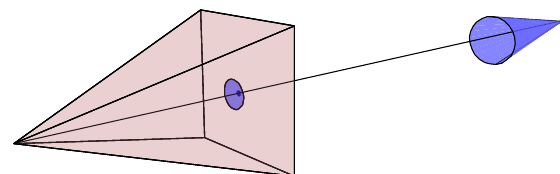
Figure 3: Visualization in refine mode. A virtual cone is gen- erated starting at one selected scene point (right) and pointing with its circular ground surface towards the camera projection center of the previous key frame. The opening angle of the cone is defined by the angular threshold for the required difference of consecutive viewing directions in refine mode, e. g. 5 degrees. Figure 4: Visualization in explore mode. The convex hull (black polygon) of all points observed in previous frames (black dots) is displayed. New points being observed in the current frame are highlighted with a blue “+”. The exploration task is to turn the camera and catch new points outside the old bounding